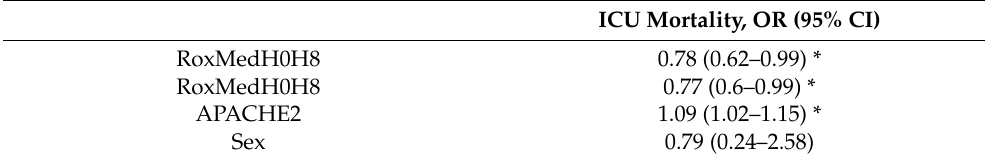
Table 3. Univariate and multivariable analyses with ROXmedH0H8, APACHEII score.